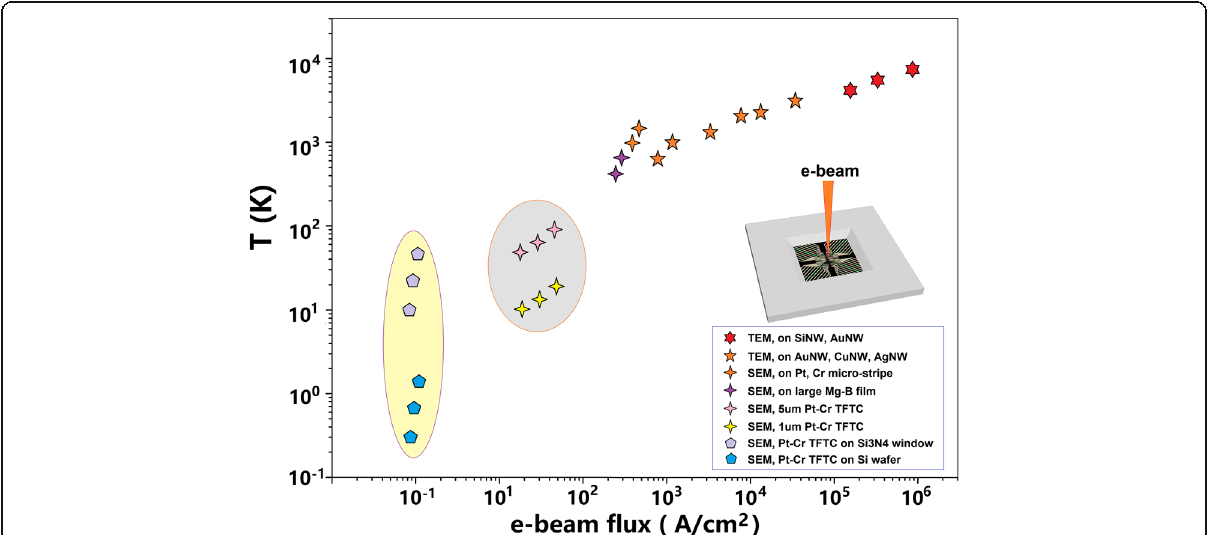
Fig. 8 An illustration for the overall picture of the nominal local temperatures under irradiation of nano-/micro-scale e-beams. The gray oval indicates the comparison between small and large TFTCs on thick Si wafers. The yellow oval indicates the comparison between TFTCs on thick Si wafers and on freestanding Si 3 N 4 thin film windows. For T > 1500 K, the data points are estimated values from morphology or phase